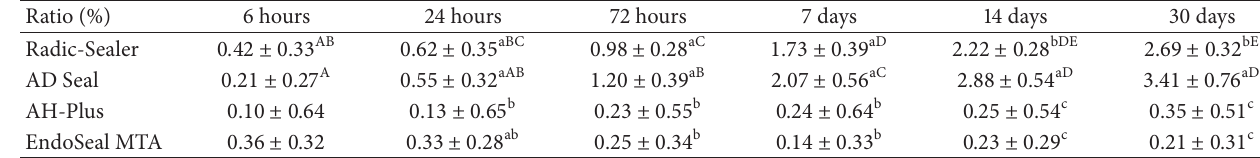
Table 4: The dimensional stability (%) of the tested sealers at various time periods (mean ± standard deviation).